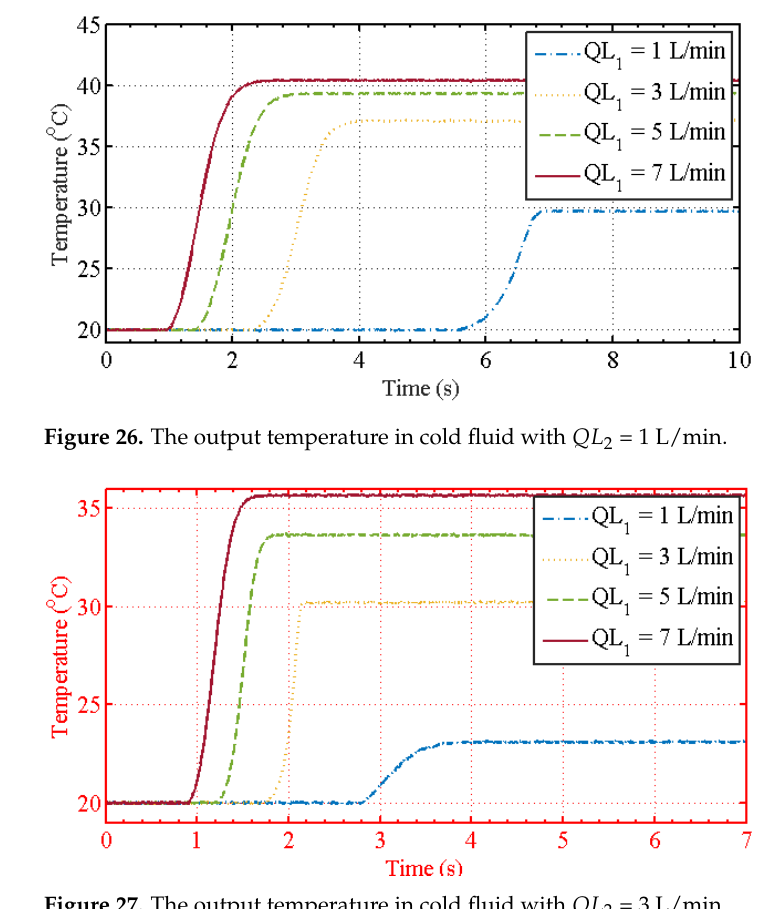
Figure 27. The output temperature in cold fluid with QL 2 = 3 L/min.